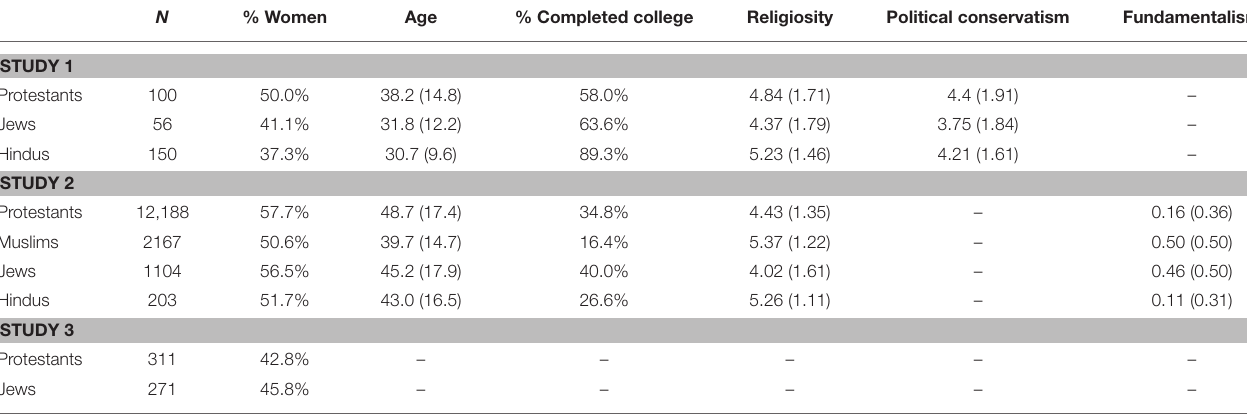
TABLE 1 | Demographics for studies